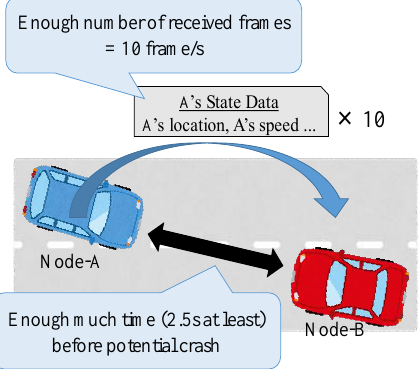
Figure 6. An abstract image of the QoS requirements of CWS for node-B to detect node-A.